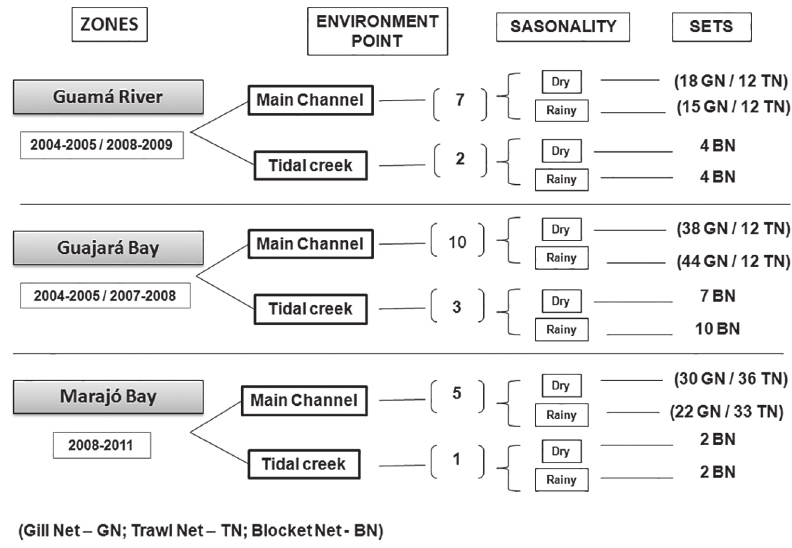
Figure 2 - Ecological descriptor and number of species by environment, season and guilds in the Guamá River, Guajará Bay and Marajó Bay, Amazon Estuary, northern